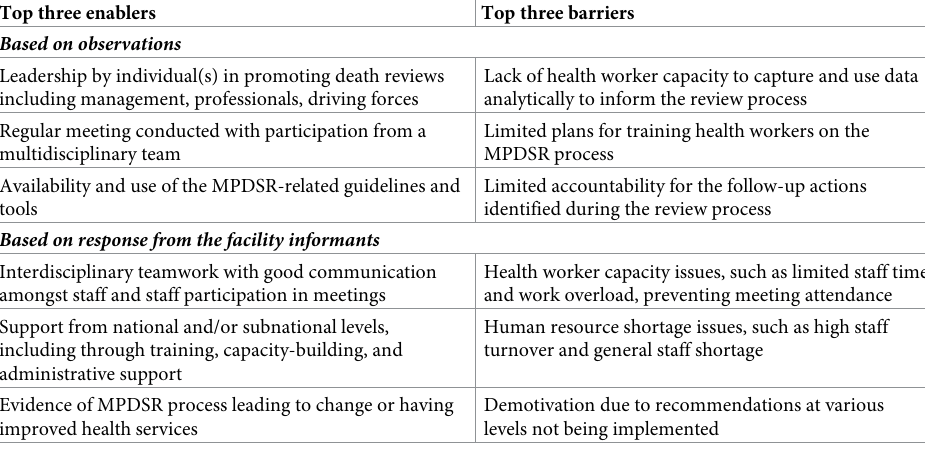
Table 5. Top enablers and barriers to MPDSR